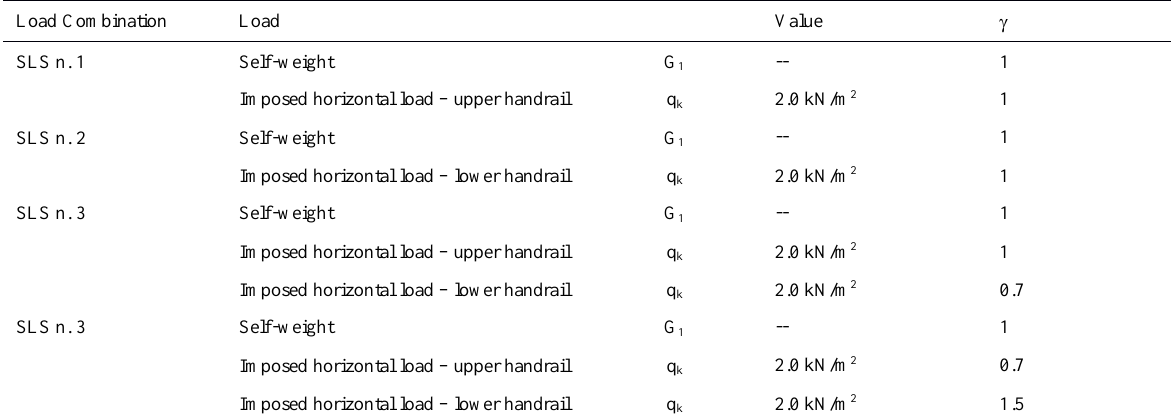
Table 6: SLS Load combinations.